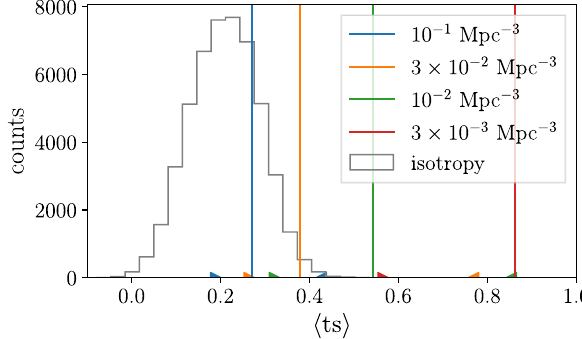
Fig. 11 Distribution of average test statistic (cid:10) ts (cid:11) iso for 10 4 isotropic skies (gray) compared to the values obtained in the benchmark 1 sim- ulation (vertical red lines) with N s = 5 (solid), N s = 10 (dashed), N s = 15 (dash-dotted), and N s = 20 (dotted) source events